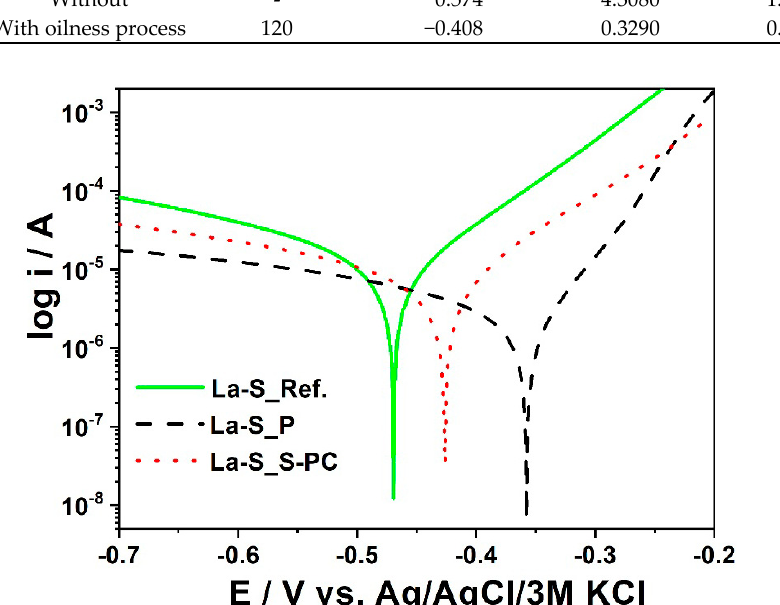
Figure 16. Polarization curves obtained for samples La ‐ S_Ref, La ‐ S_P, and La ‐ S_PC.